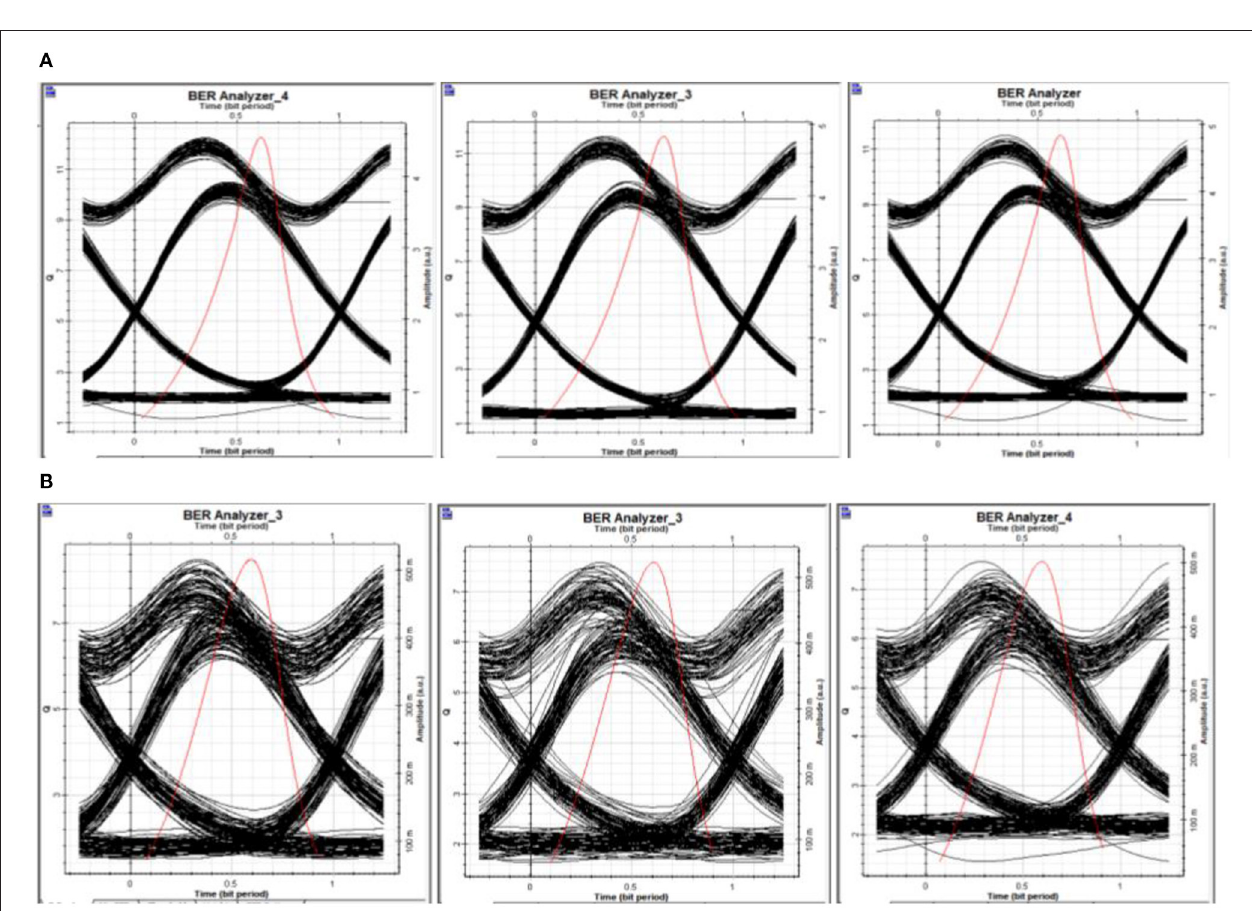
FIGURE 14 | The eye diagrams for WDM-based RoF system, with DCF and FBG for 100 GHz channel spacing. (A) The eye diagrams at channels 1, 8, and 16 at − 5 dBm input power. (B) The eye diagrams at channels 1, 8, and 16 at − 15 dBm input power.